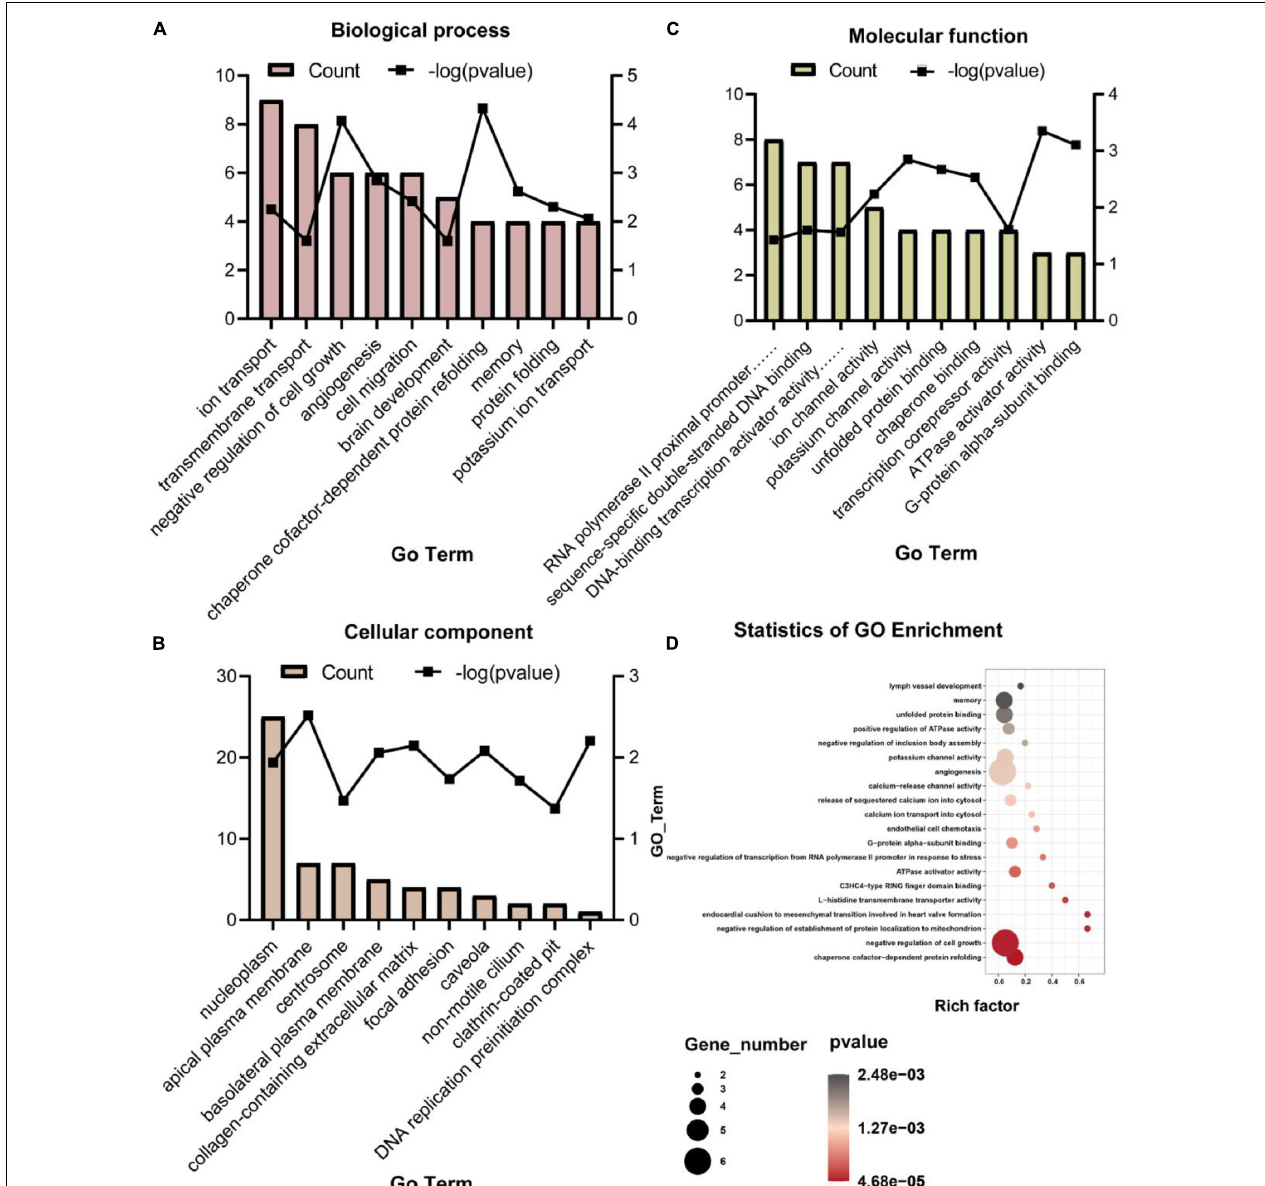
FIGURE 4 | Gene ontology items with top 10 counts and significant enrichment ( P < 0.05) in BP (A) , CC (B) , and MF (C) , and the statistics of the top 20 terms with the most significant enrichment (D)